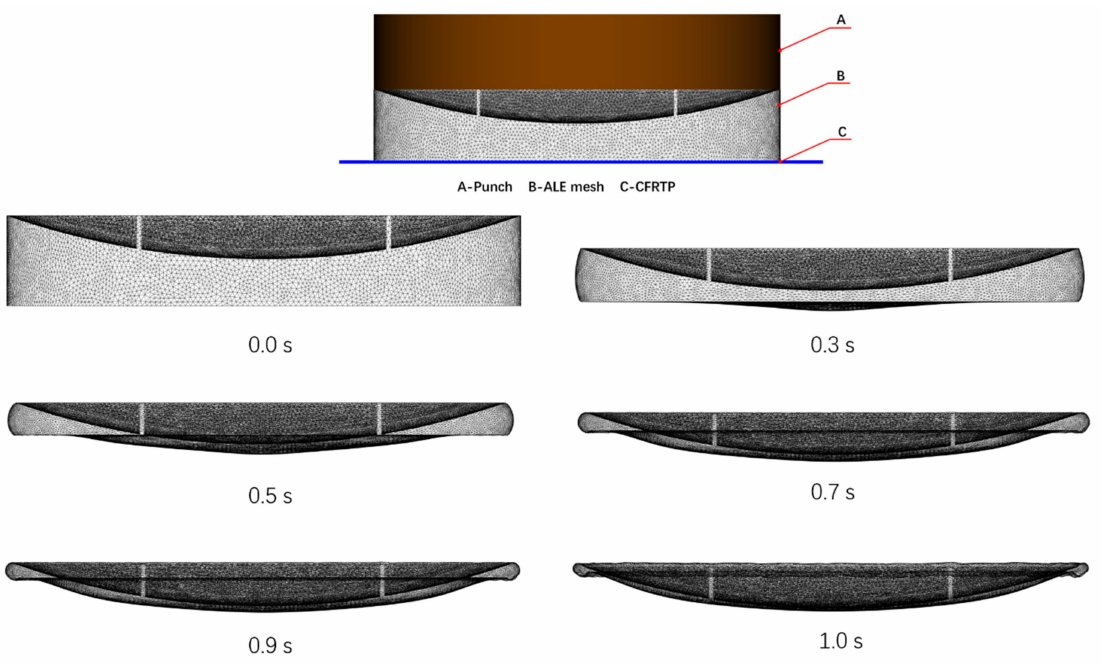
Figure 13. Compression mesh deformation.